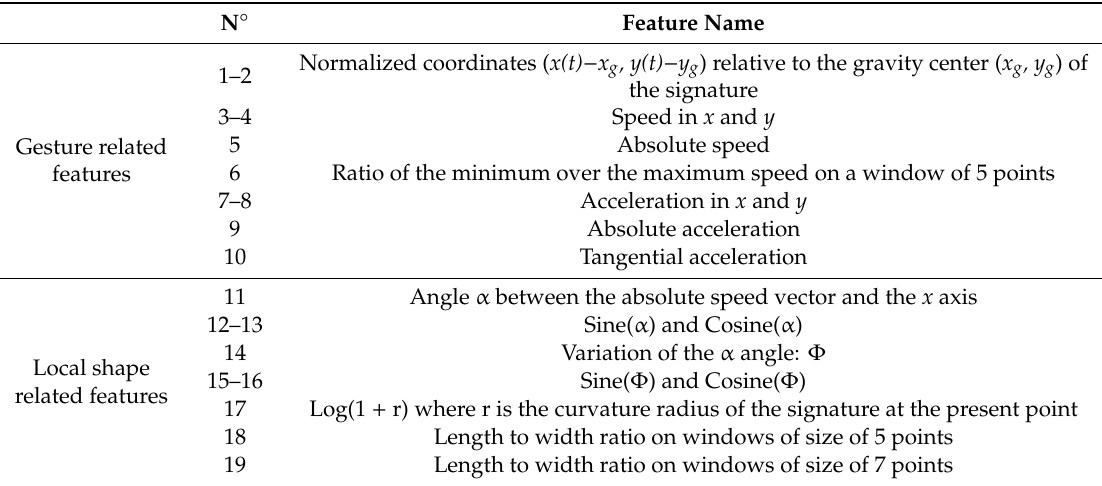
Table A1. The 19 dynamic features extracted point-wise on all signature